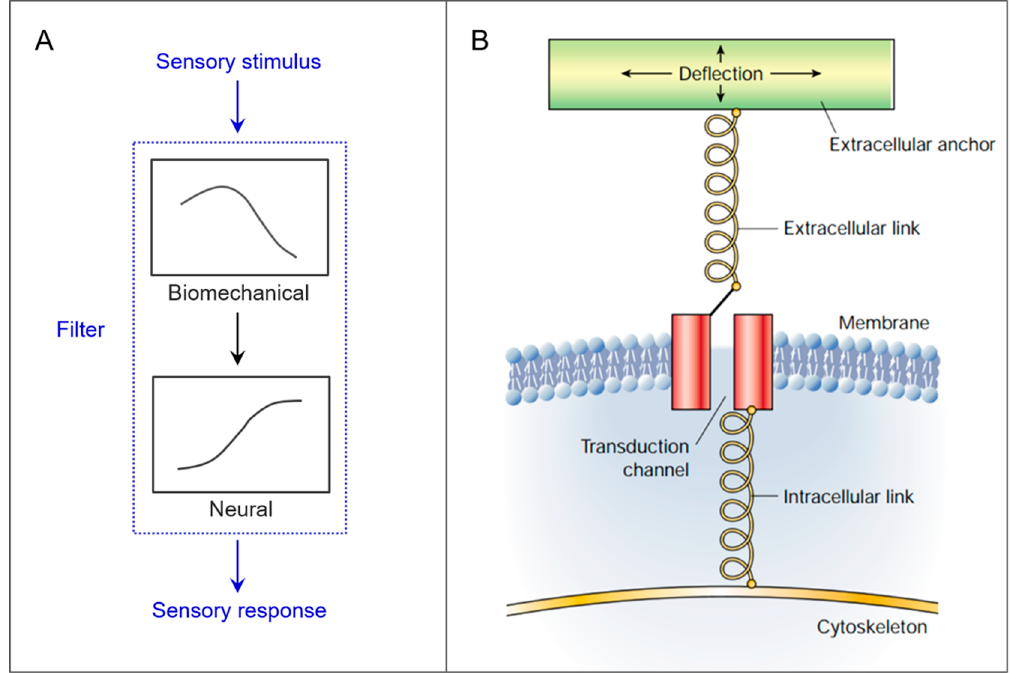
Figure 1. General features of mechanical sensing in nature. ( A ) The outer stimuli are filtered both biomechanically and neurally, before producing sensory responses in the living organism (adapted from [1] by permission of Oxford University Press). ( B ) General features of mechanosensory transduction at the cellular level (reprinted by permission from Springer, [8]). Transduction of the stimuli occurs after deformations and/or displacements of structures.